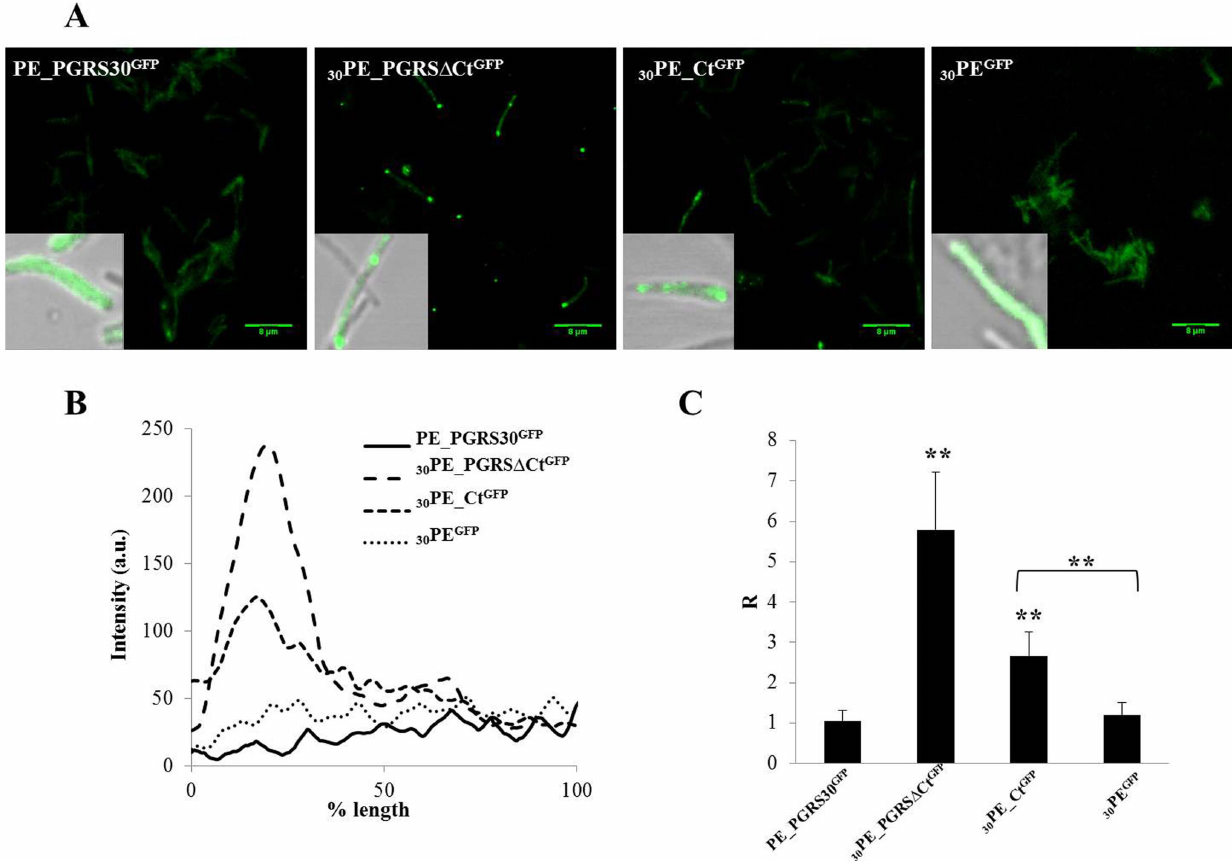
Figure 3. Polar localization of PE_PGRS30 GFP spatial distribution in M.smegmatis . A) Confocal images of M. smegmatis expressing PE_PGRS30 GFP and its functional GFP-tagged chimeras obtained with a 63 6 objective. In the inbox, a 100 6 image obtained overlapping green channel and transmission image is shown. B) Sample line profile obtained quantifying the fluorescence along mycobacterial cell. C) Ratio between the GFP emission intensity at bacterium pole (considered as the value 200 nm far from the bacterium border) and GFP emission intensity in the cytoplasm (measured at the 50% of the bacterium length). Twenty R values were analyzed for each M. smegmatis strain under study. Two-tailed Student’s t -test was used to analyze R ratio ( * p , 0.05, ** p , 0.01).